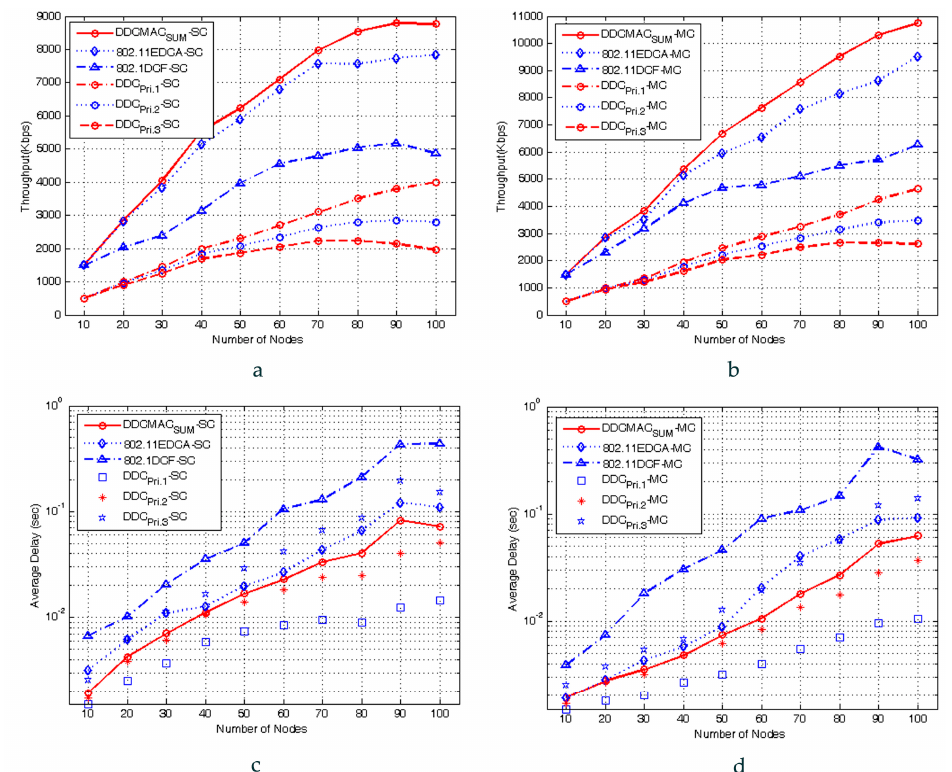
Figure 10. Throughput and average delay performances versus number of nodes in 1-hop OC mode. ( a ) Throughput in single-channel environment; ( b ) Throughput in multi-channel environment; ( c ) average delay in single-channel environment; ( d ) average delay in multi-channel environment